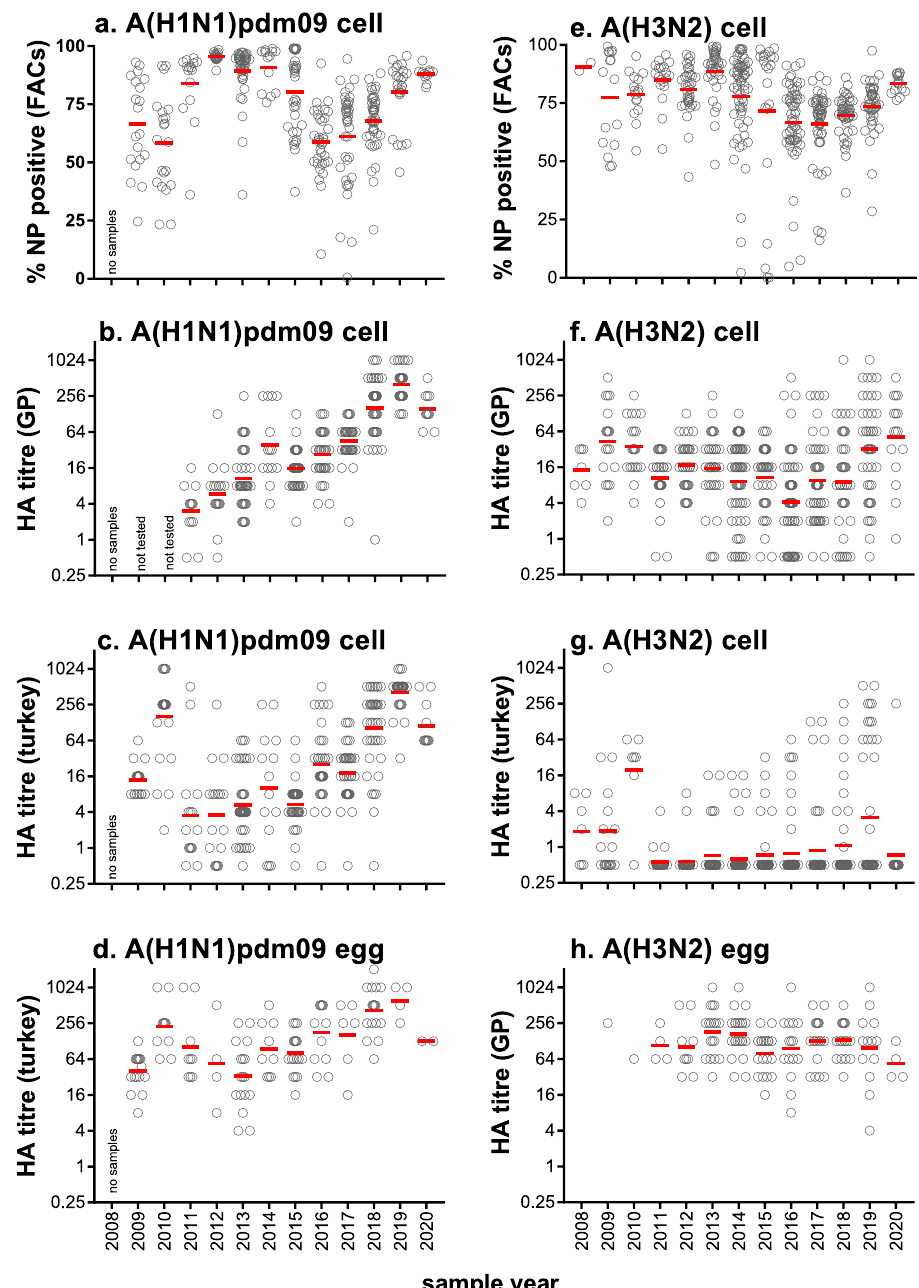
Fig. 4 HA titres of in fl uenza A isolates to GP and turkey RBC, from 2008 – 2020. a , e Cell-grown A(H1N1)pdm09 and A(H3N2) viruses were assessed for infectivity of cells by fl ow cytometry. The red bar indicates the mean. HA titres of cell-grown isolates to GP RBC ( b , f ) and turkey RBC ( c , g ). d The HA titre of egg-grown A(H1N1)pdm09 viruses was measured using turkey RBC. h The HA titre of egg-grown A(H3N2) viruses was measured using GP RBC. ( b – d , f – h ) Red bar indicates geometric mean in fl uenza B viruses. Adaptive mutations in the NA gene of cell- (see Supplementary Information, Supplementary Table 2). Follow- grown viruses was rare, observed only in 7% (1/15) of A(H1N1) ing passage in eggs, the proportion of viruses with mutations was pdm09 viruses and none in A(H3N2) (0/25) or in fl uenza B (0/9) similar for both in fl uenza A subtypes and in fl uenza B viruses (A viruses (Supplementary Information, Supplementary Table 2). (H1N1)pdm09 — 86% (24/28), A(H3N2) — 100% (26/26), B — 93% Mutations were located mainly in the head of the HA protein in (13/14)). In fl uenza B viruses were less likely to acquire mutations in both egg and cell passaged viruses (Fig. 6 and Supplementary the HA following passage in cells (3% 1/36), than in fl uenza A Information, Supplementary Table 2). Over twice as many viruses (A(H1N1)pdm09 — 11% (7/66), A(H3N2) — 16% (10/64) mutation sites were located in antigenic sites for A(H3N2) viruses (Fig. 6). The NA gene sequences were also assessed by consensus passaged in eggs (65% 13/20) than passaged in cells (30% 3/10) Sanger sequencing. Adaptive mutations in the NA gene of egg- (Fig. 6b), and for in fl uenza B viruses (eggs 100% 3/3, cells 0% 0/2)- grown viruses was less common, observed in 40% (6/15) of A (Fig. 6c). Similar proportions of mutation sites were located in the (H1N1)pdm09 viruses, 8% (2/26) of A(H3N2) viruses and no (0/9)